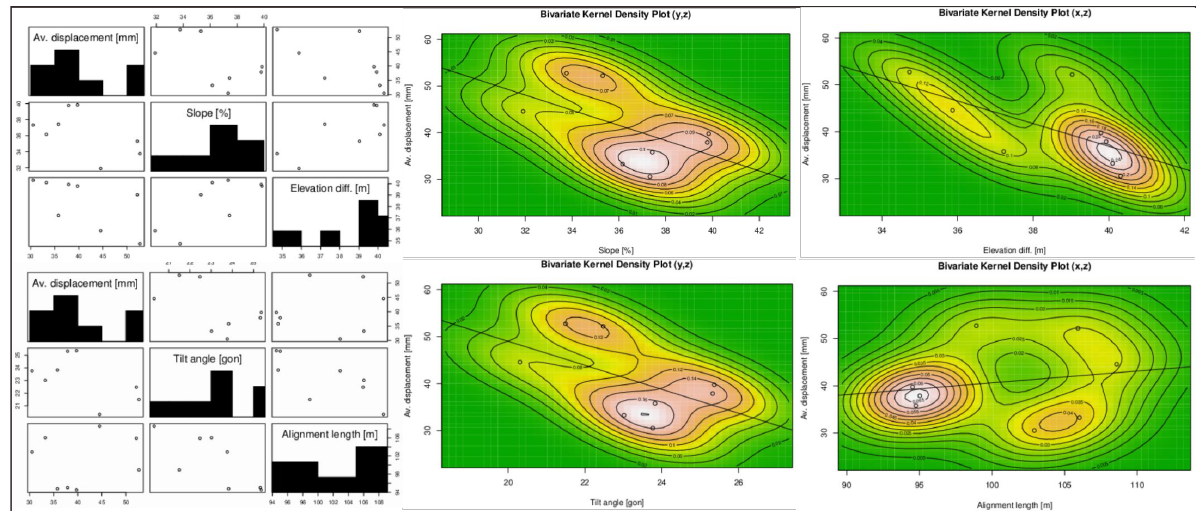
Figure 19. Bivariate Kernel density plots illustrating low correlation between the average displacement and the alignment parameters.